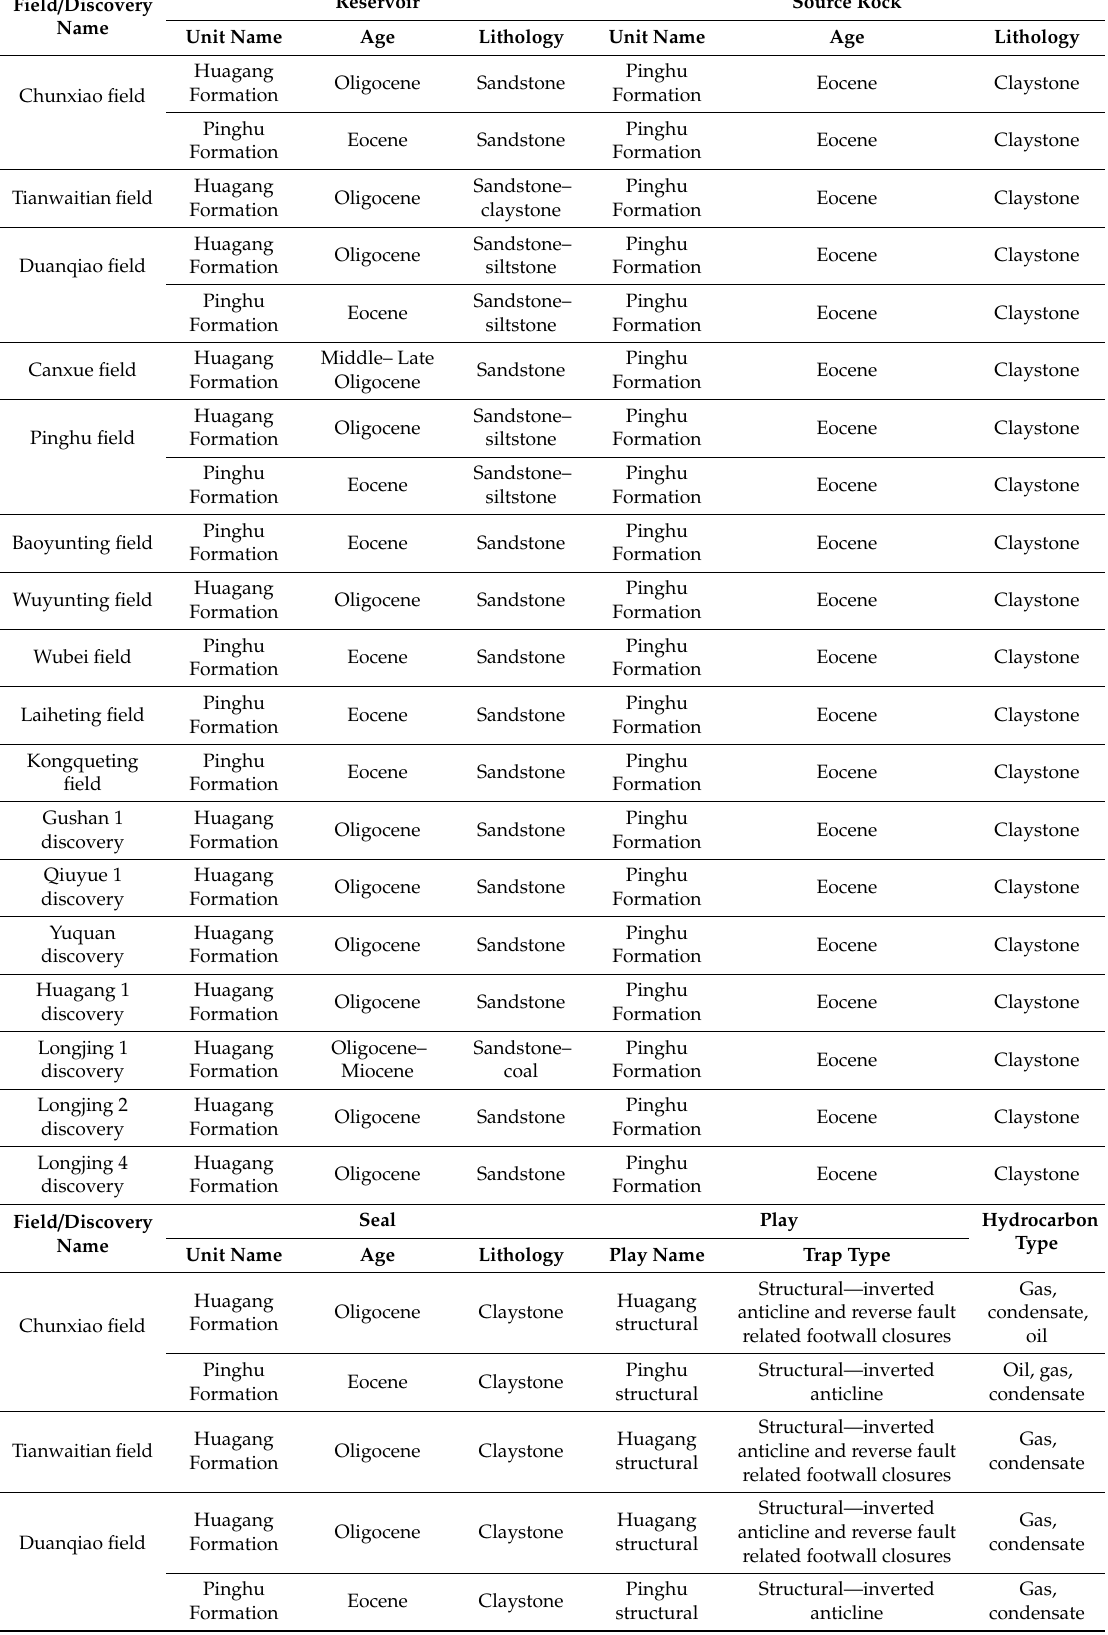
Table 1. Summary of hydrocarbon fields and discoveries of the Xihu